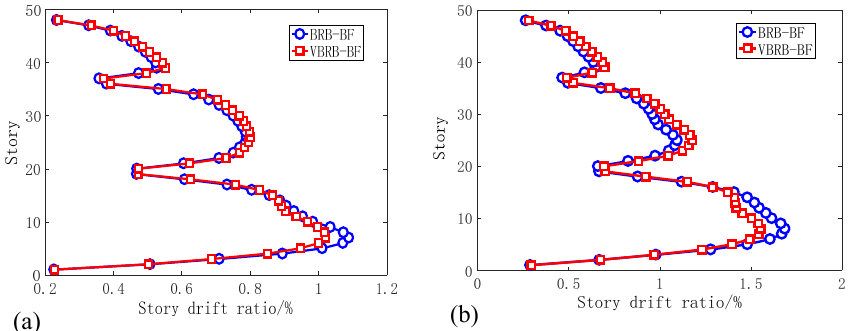
Figure 13. Average responses of the maximum lateral drift ratio: ( a ) PGA = 400 cm/s 2 (MCE); and ( b ) PGA = 620 cm/s 2 (SRE).